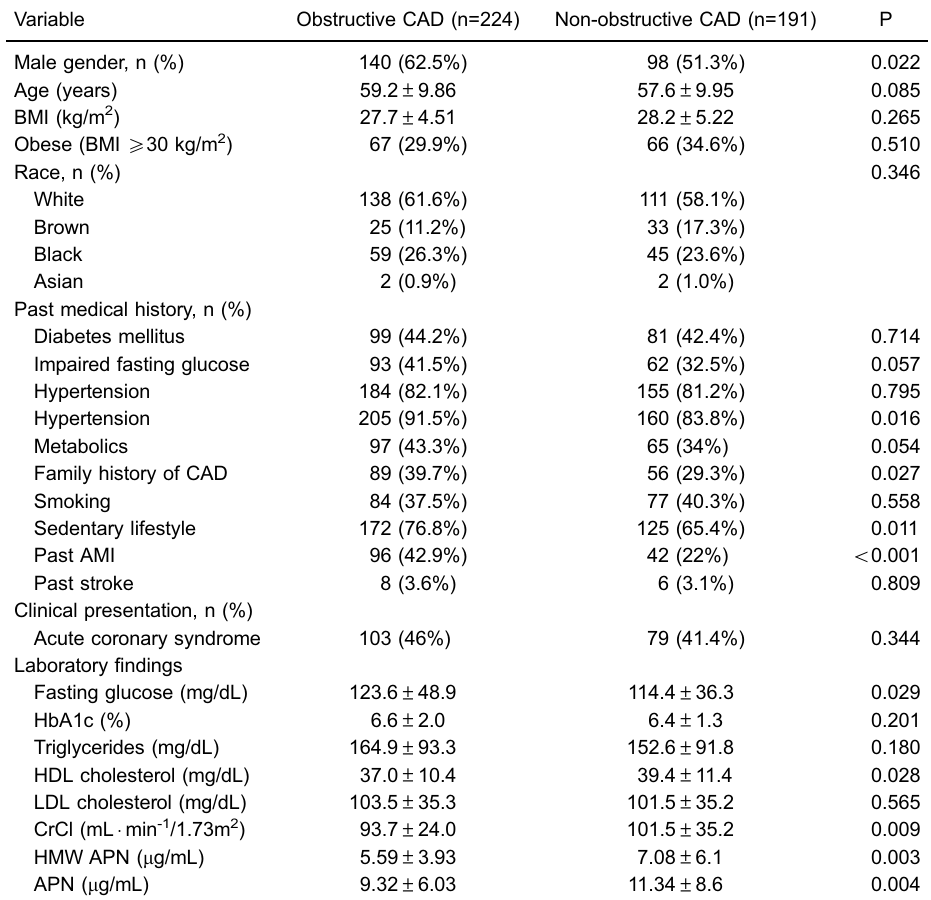
Table 1. Demographic, clinical, and laboratory characteristics of patients undergoing elective coronary angiography, according to the presence of coronary artery disease (CAD). Variable Obstructive CAD (n=224)